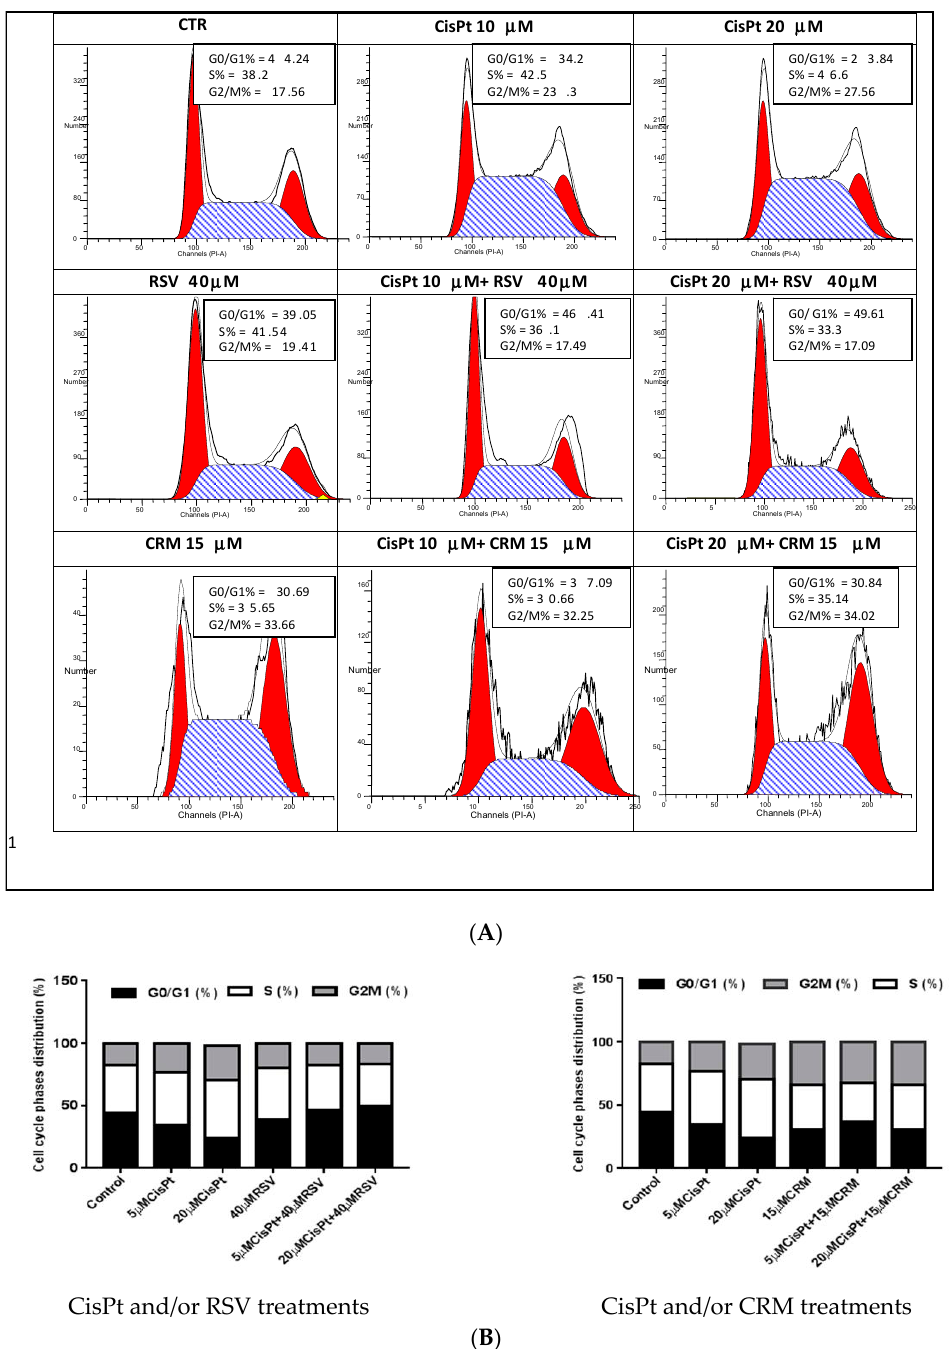
Figure 5. The effect of treatments with CisPt, RSV, CRM applied independently or in combination on tumor cells PE/CA-PJ49 on cell cycle phases distribution. ( A ) flow cytometry histograms; ( B ) cell cycle phases distribution (%).